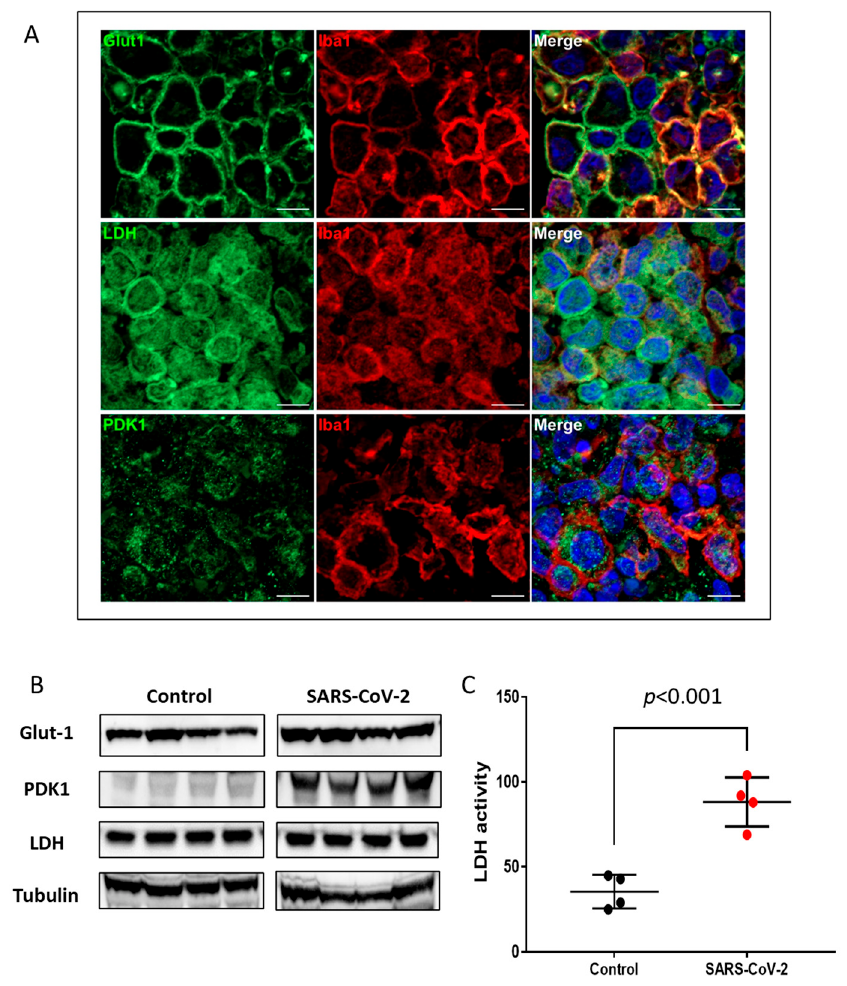
ture. Nuclei were counterstained with Hoechst 33342 (blue). Scale bars: 20 µ m. ( B ) Semiquantitative analysis of HIF-1 α expression in consolidated and nonconsolidated regions of SARS-CoV-2-infected lungs at 4 dpi. A total of 8–10 high power fields (HPFs) from consolidated and nonconsolidated regions were analyzed per lung section for each infected animal ( n = 4). Plotted values represent the percent positive HIF-1 α nuclei as a function of total nuclei for each HPF. * p < 0.05, Mann–Whitney test. ( C ) Immunoblotting showing HIF-1 α expression in nuclear extracts from lung tissue lysates of SARS-CoV-2-infected and non-infected hamsters (upper panel) and Lamin B1 as loading control (lower panel). Densitometric analysis for relative expression of HIF-1 α was done by BioRad Image Lab 5.2.1 software (Supplementary Figure S3). DIC = differential interference contrast.